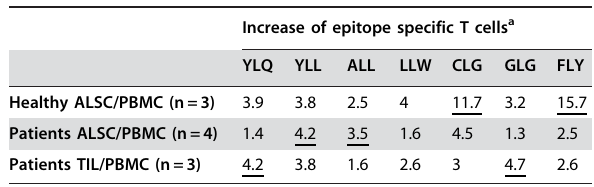
Table 4. A activation of EBV epitope specific T cells in auto-